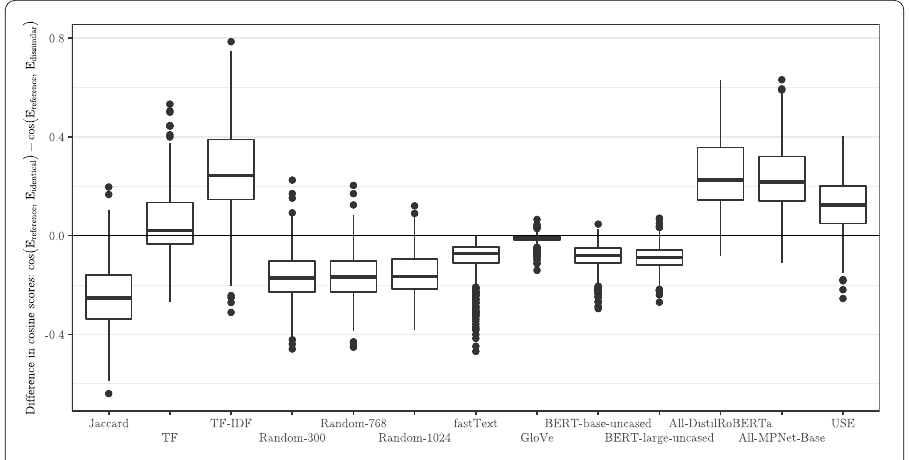
Figure 3 The distribution of the cosine similarity difference scores for Hypothesis 2 across text representation approaches. The y -axis indicates the size and direction of the differences. The more positive the